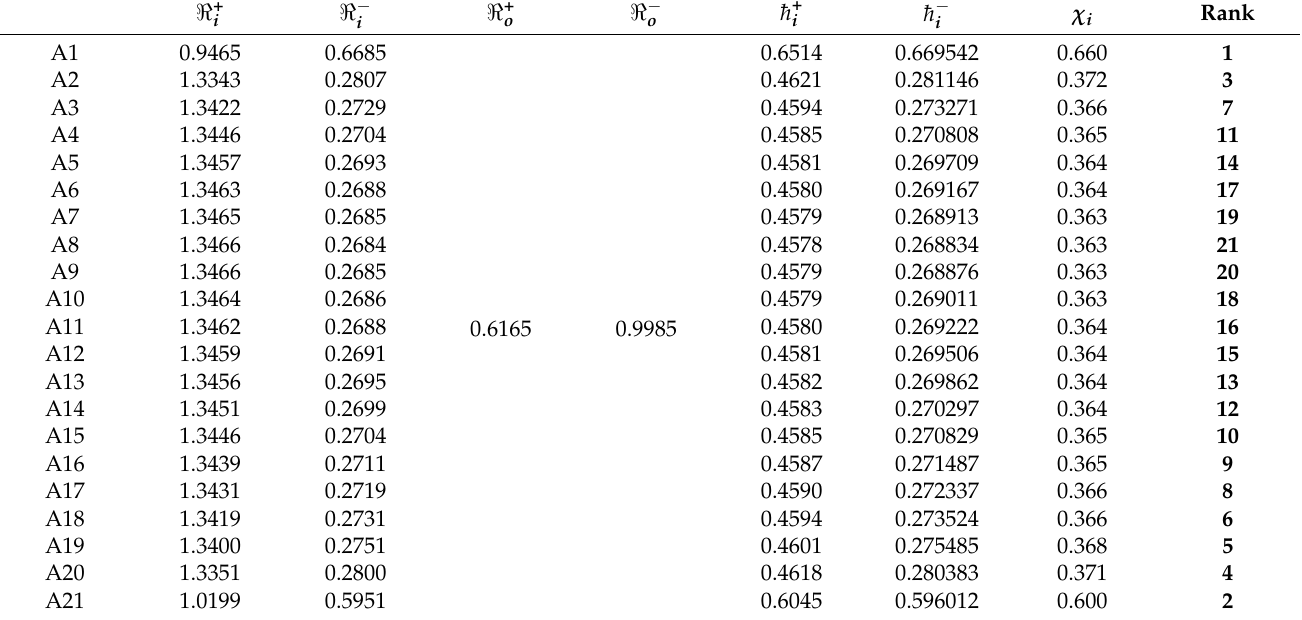
Table 6. Results of applying the Rough CRADIS